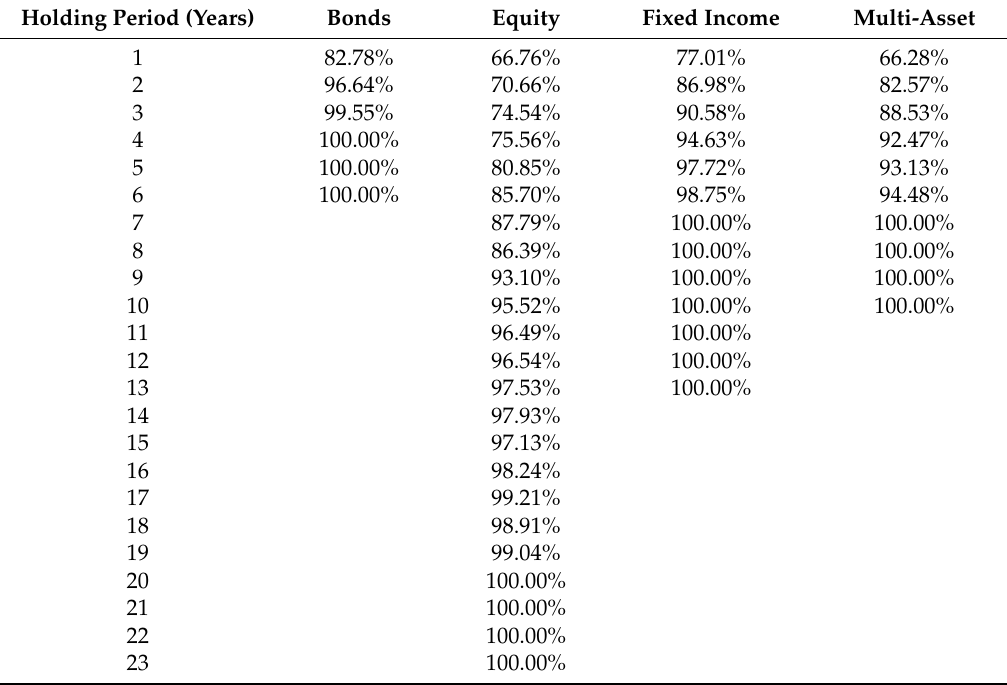
Table 4. NASDAQ ETF Positive Return Probabilities by Asset Class.